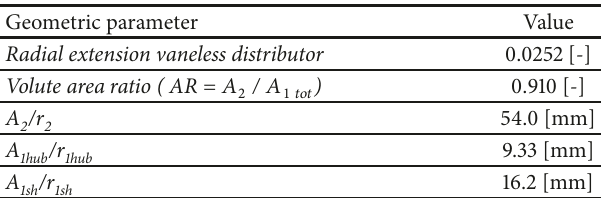
Table 1: Volute geometrical